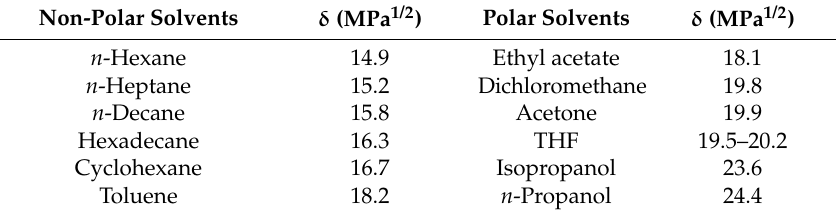
Table 1. Solubility parameters ( δ ) of the most usual non-polar and polar